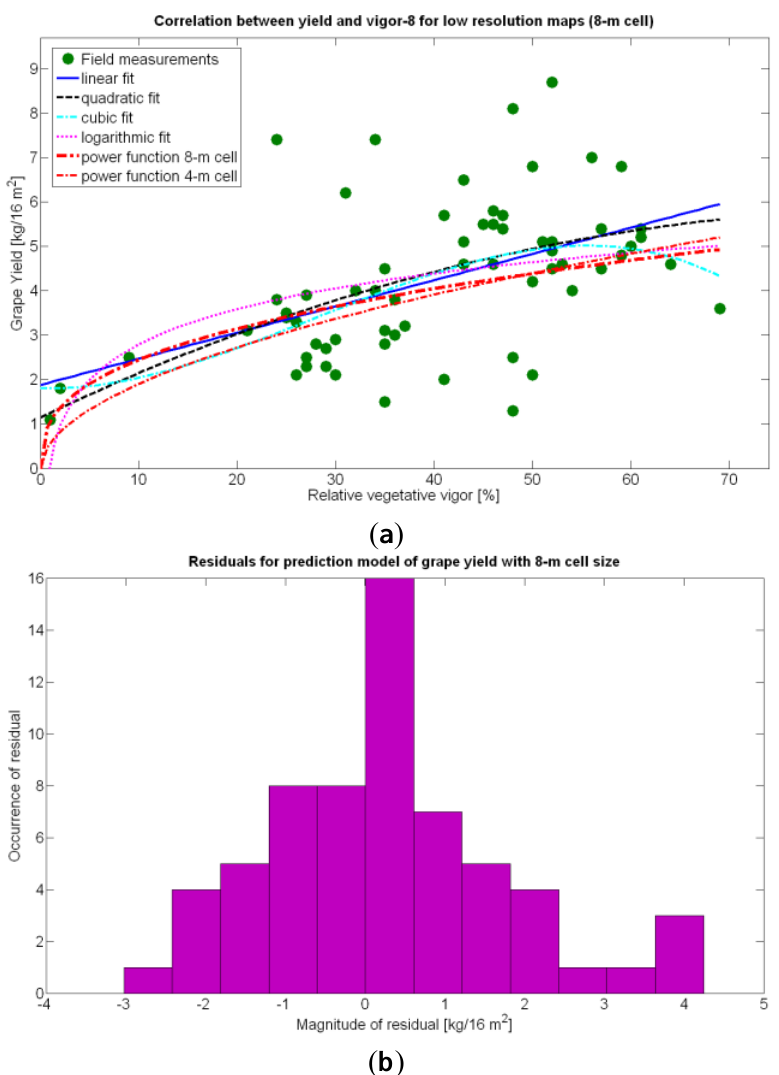
Figure 30. ( a ) Prediction models for low resolution CB maps of yield as a function of